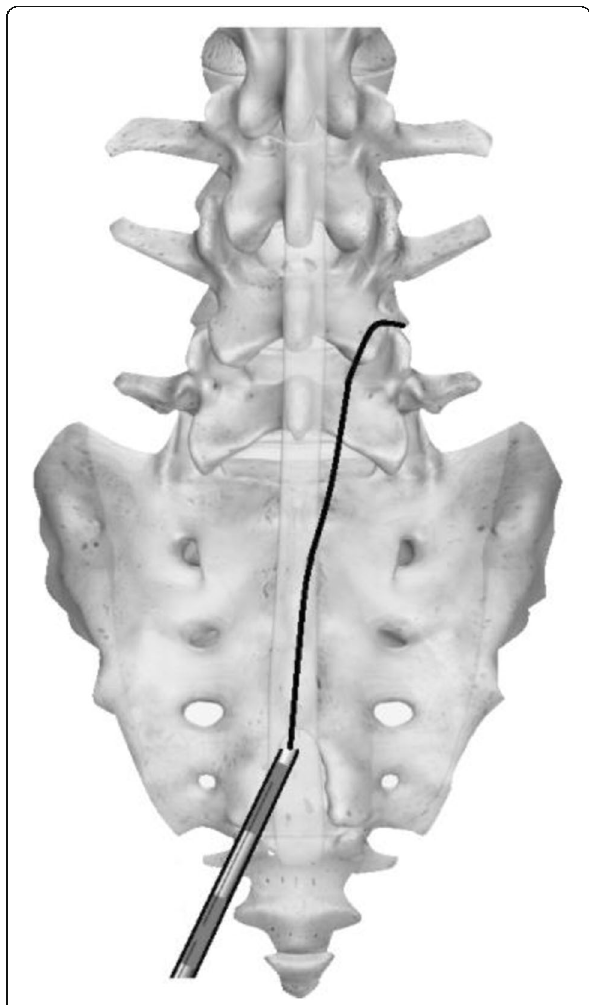
Fig. 1 Fiber optic endoscope is introduced into the epidural space and directed cephalically to the target